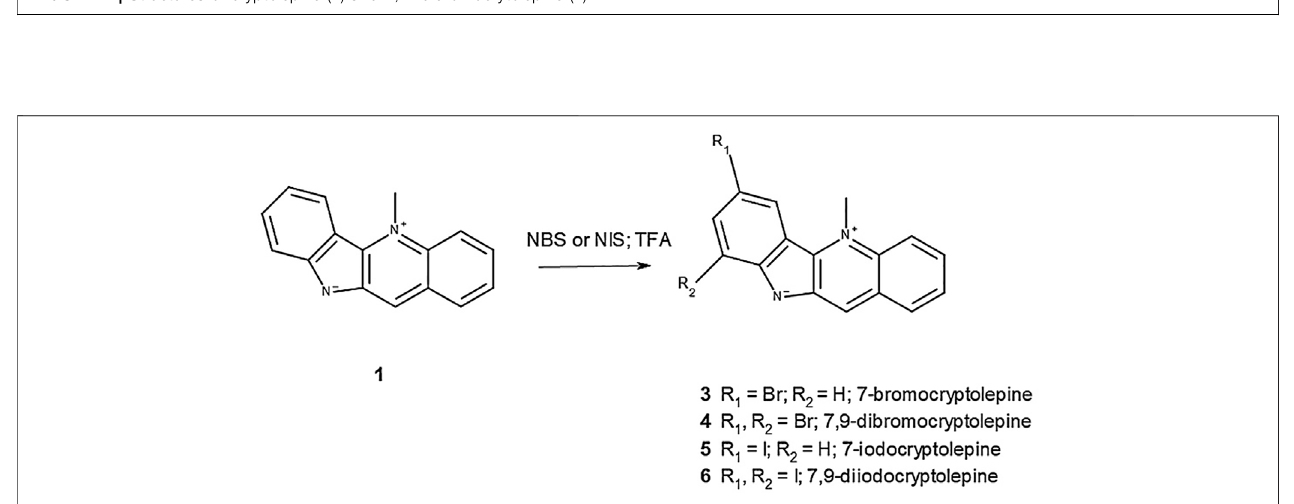
FIGURE 2 | Semi-synthesis of brominated and iodinated derivatives of 1 .